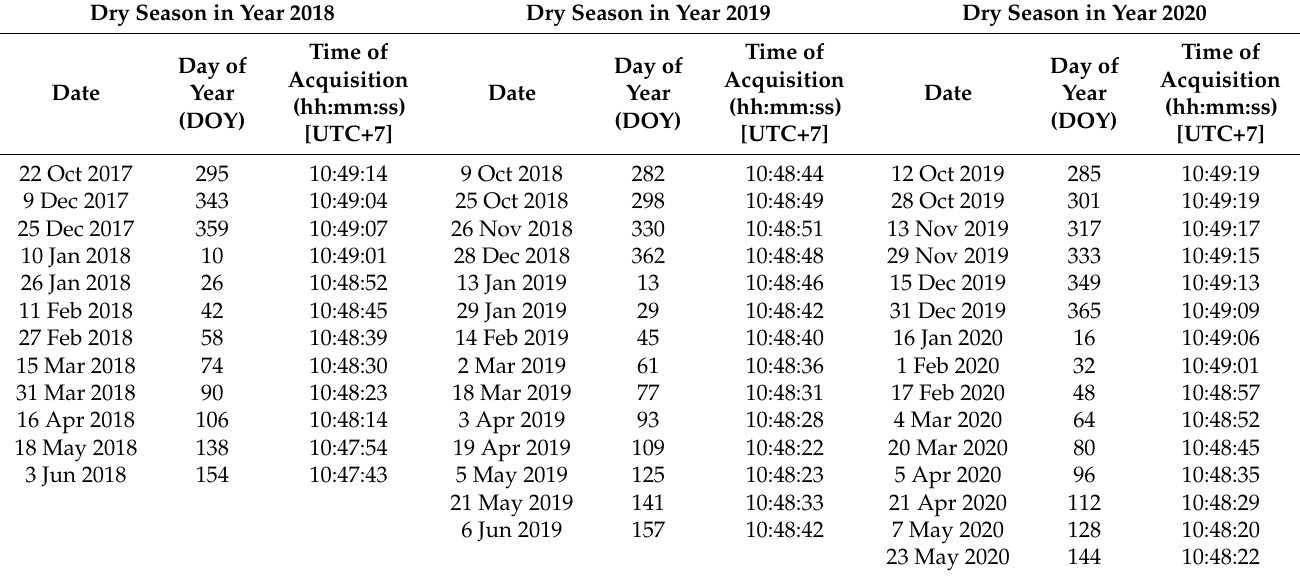
Table 1. Landsat-8 OLI/TIRS images (Path 131/Row 47) for the study